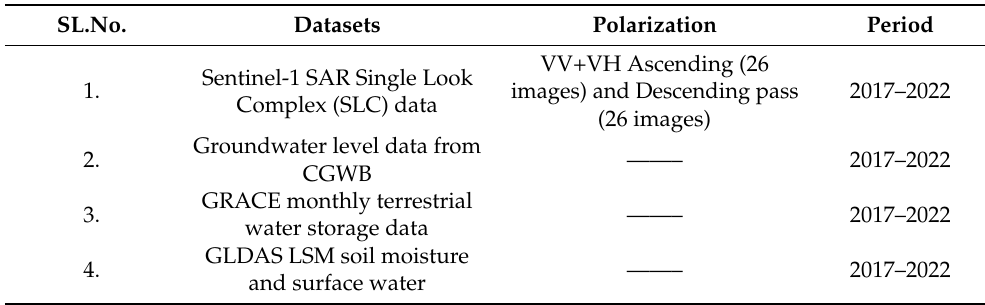
Table 1. Datasets